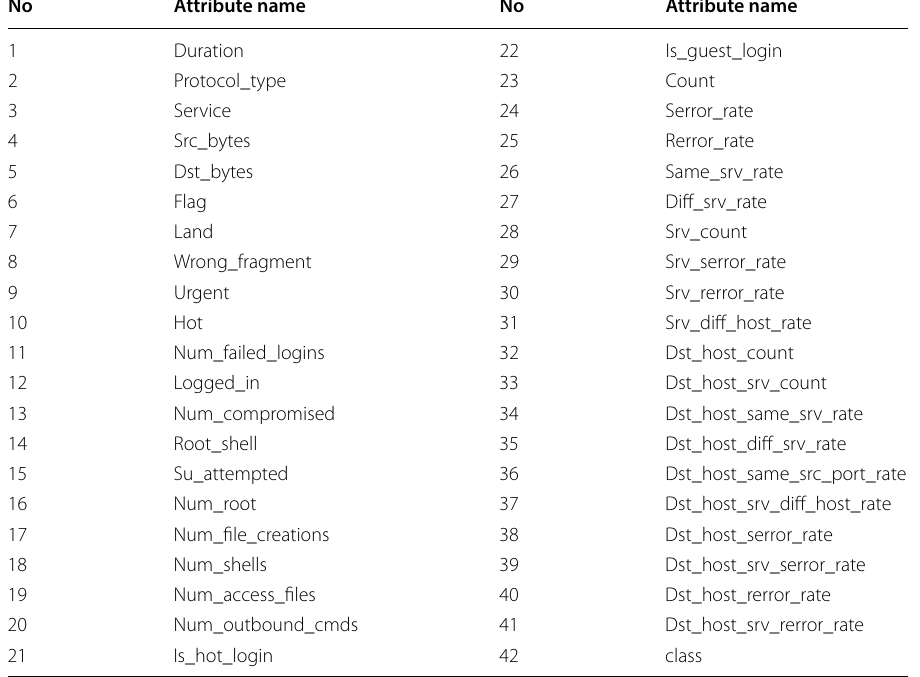
Table 2 KDD99 dataset